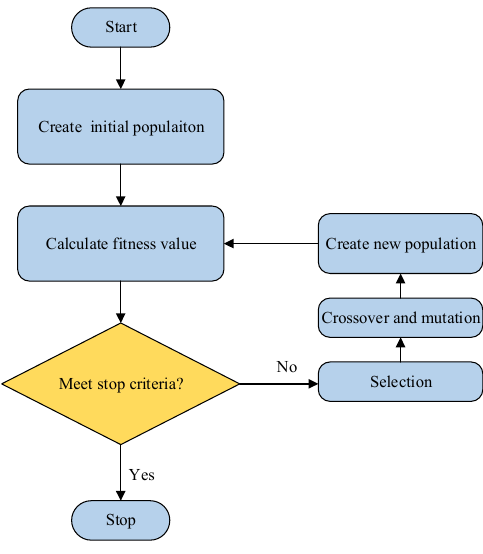
Figure 6. Working mechanism flowchart of the GA.